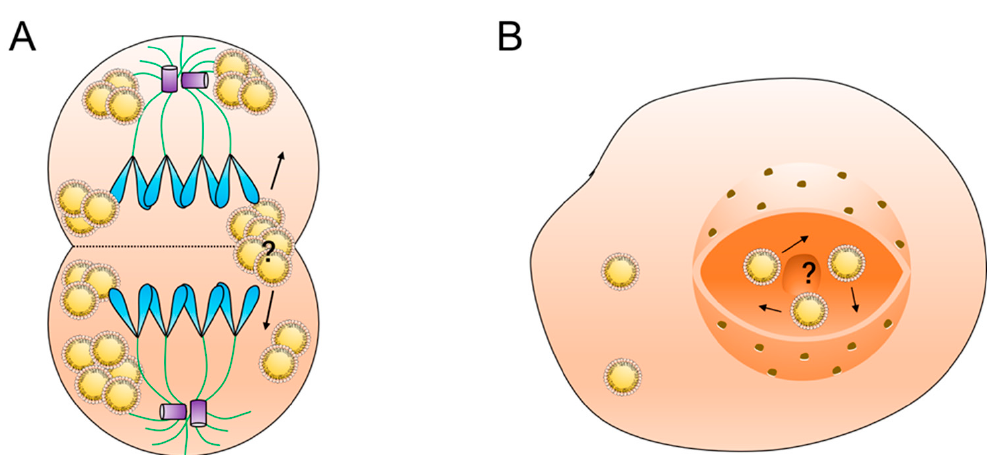
Figure 3. Questions in lipid droplet motility research: ( A ) the molecular mechanism of lipid droplet distribution during cell mitosis and ( B ) the motility mechanism of nuclear lipid droplets.